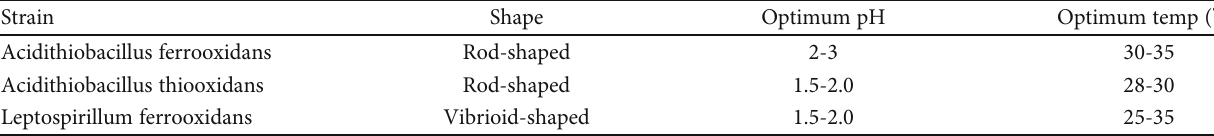
Table 1: Physical and chemical properties of microorganisms.